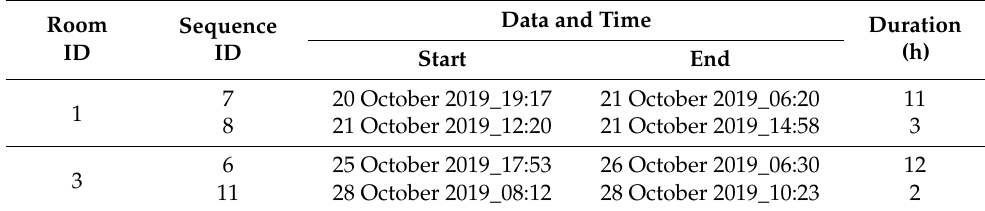
Table 4. Randomly generated long sequences for testing